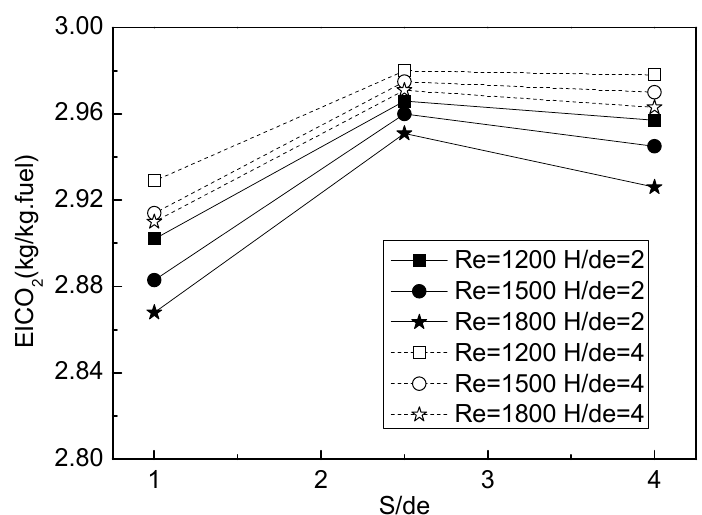
Figure 6. EICO 2 of slot LPG premixed flame array at different conditions.